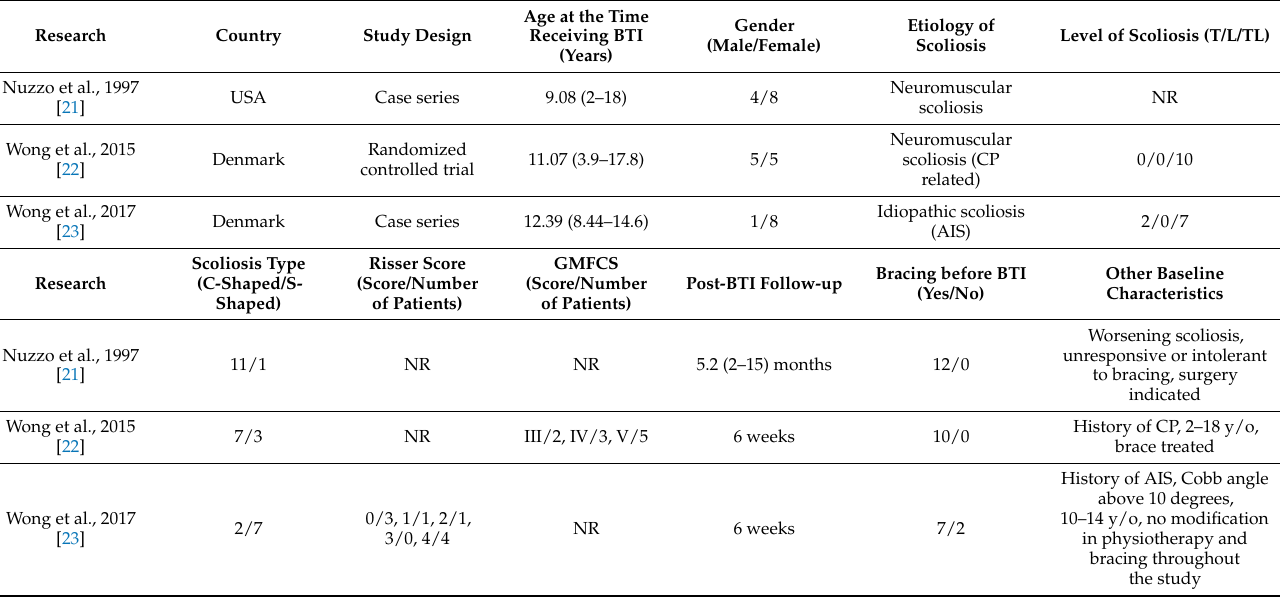
Table 1. The detailed characteristics of all included study.